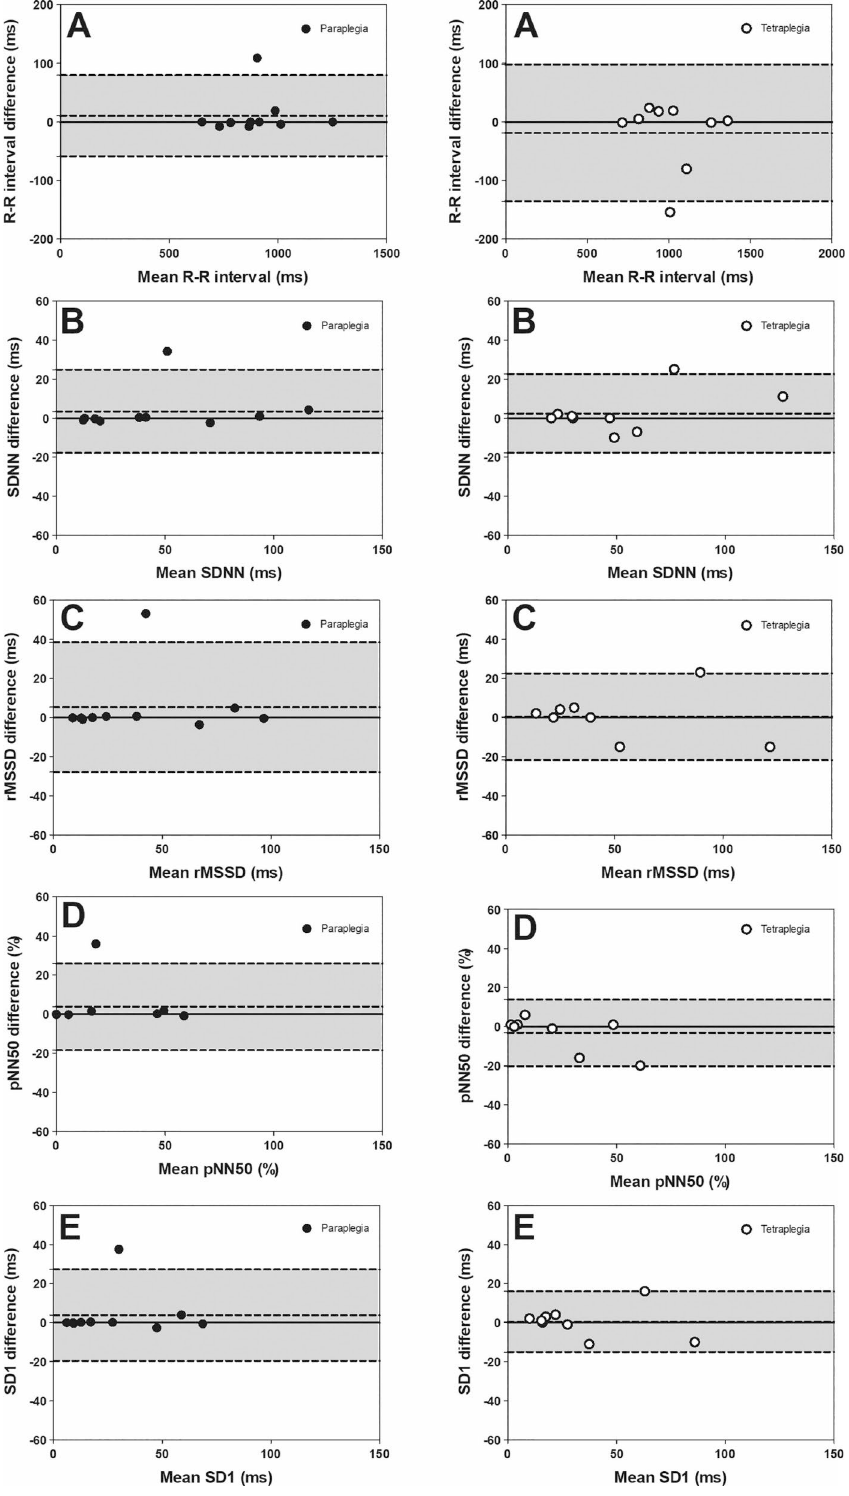
Figure 1 - Bland-Altman plot showing individual differences between HRV indices in time domain derived from ECG vs. Polar V800 in paraplegia (n = 10) and tetraplegia (n = 9) groups. The first and third horizontal dashed lines in each graph represent the 95% limits of agreement. S d = standard deviation of the differences. ( A ) R-R interval = average of all normal R-R intervals; ( B ) SDNN = standard deviation of all normal R-R intervals; ( C ) rMSSD = square root of the sum of successive differences between adjacent normal R-R intervals squared; ( D ) pNN50 = percentage of successive R-R intervals that differ by more than 50 ms; ( E ) SD1 = Poincaré plot standard deviation perpendicular the line of